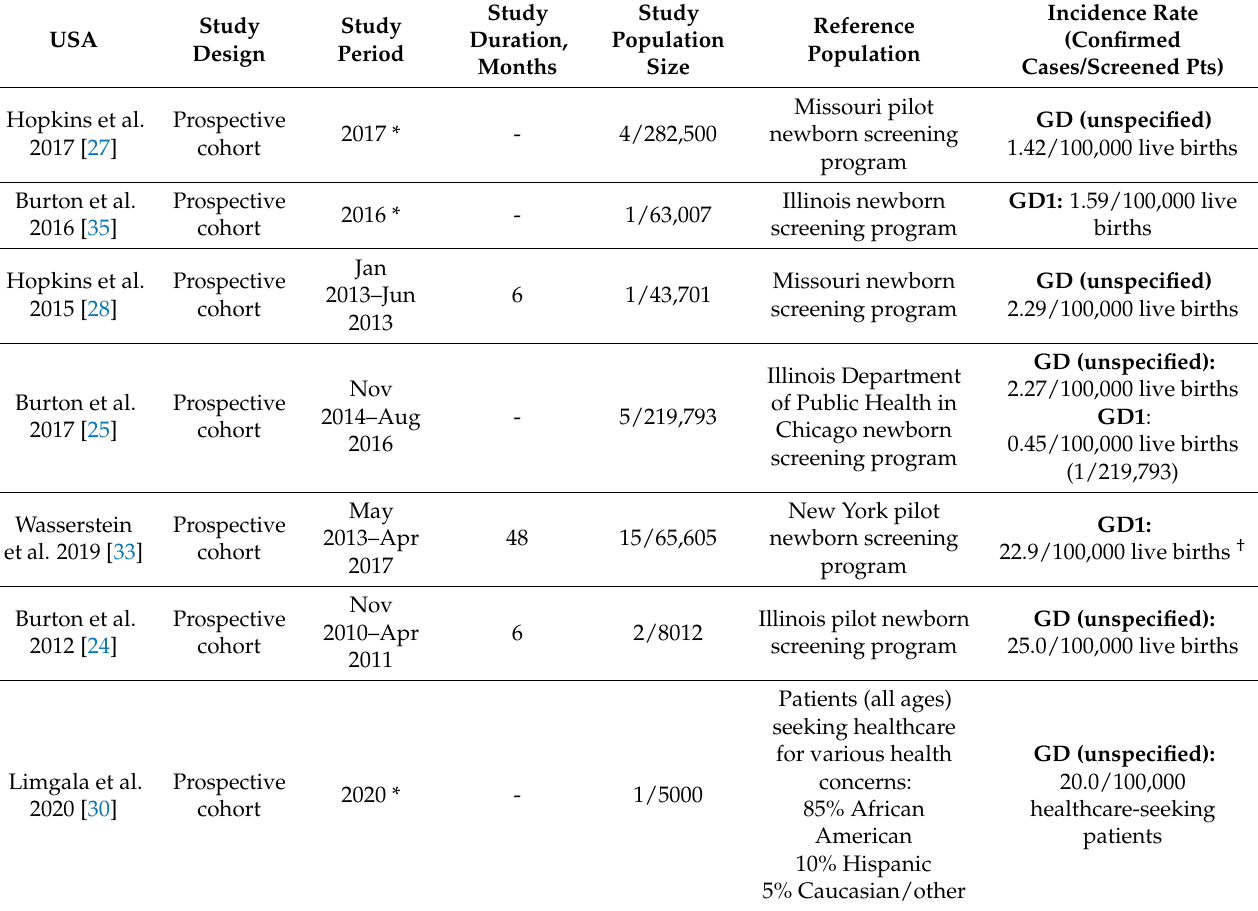
Table 4. GD incidence: North